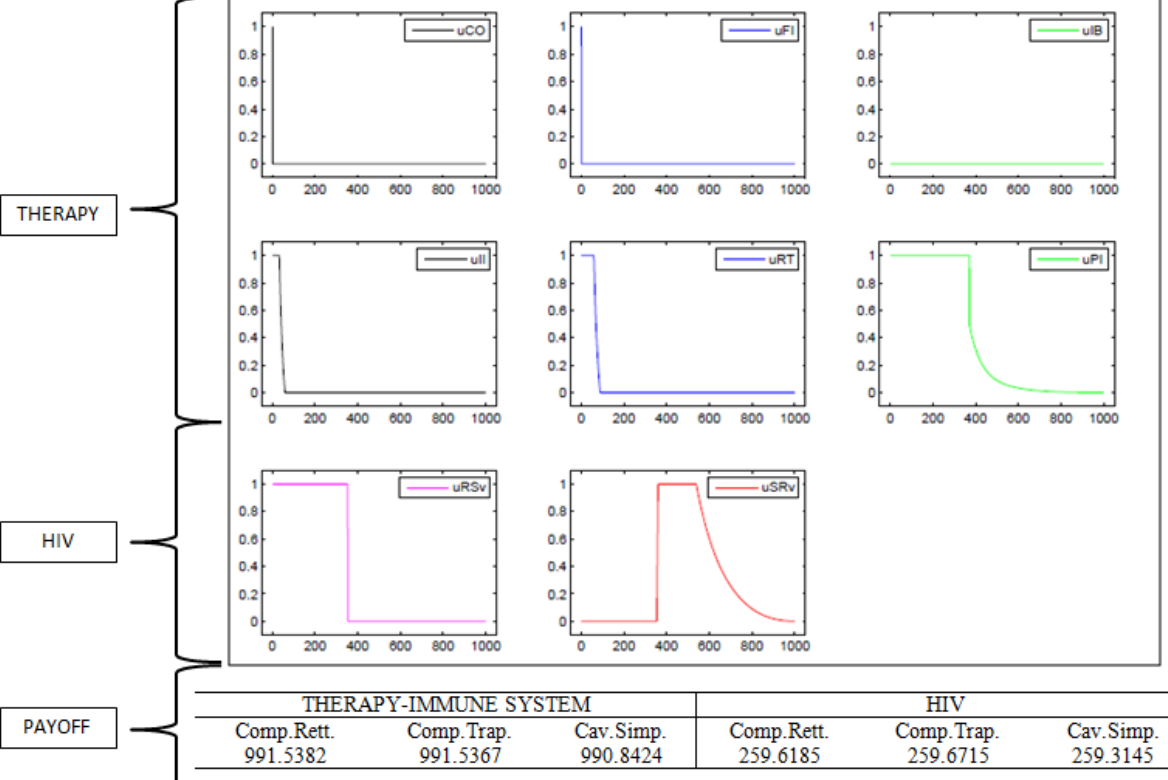
Figure 1. Equilibrium strategies and payoffs (concave